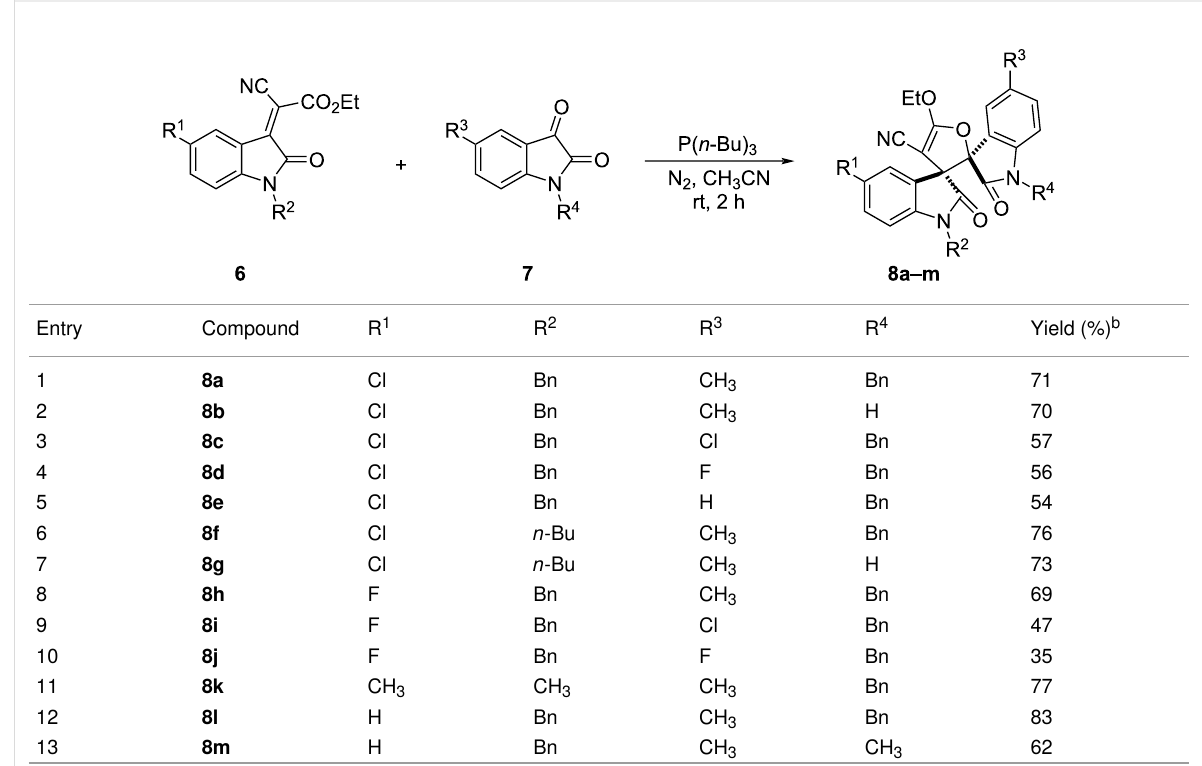
Table 4: Reaction of ethyl isatylidene cyanoacetates and isatins. a